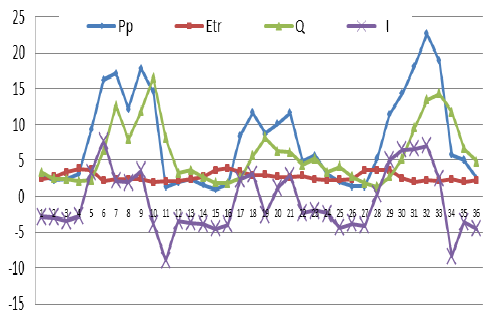
Figure 3. Monthly Accumulated values (km3) from Boca del Rio catchment. Precipitation (Pp), actual evapotranspiration (Etr), Runnoff (Q) and ΔI (Pp - [ETr + Q]) difference, of three years of analysis 2008 (months 1 a12), 2009 (months 13 to 24)